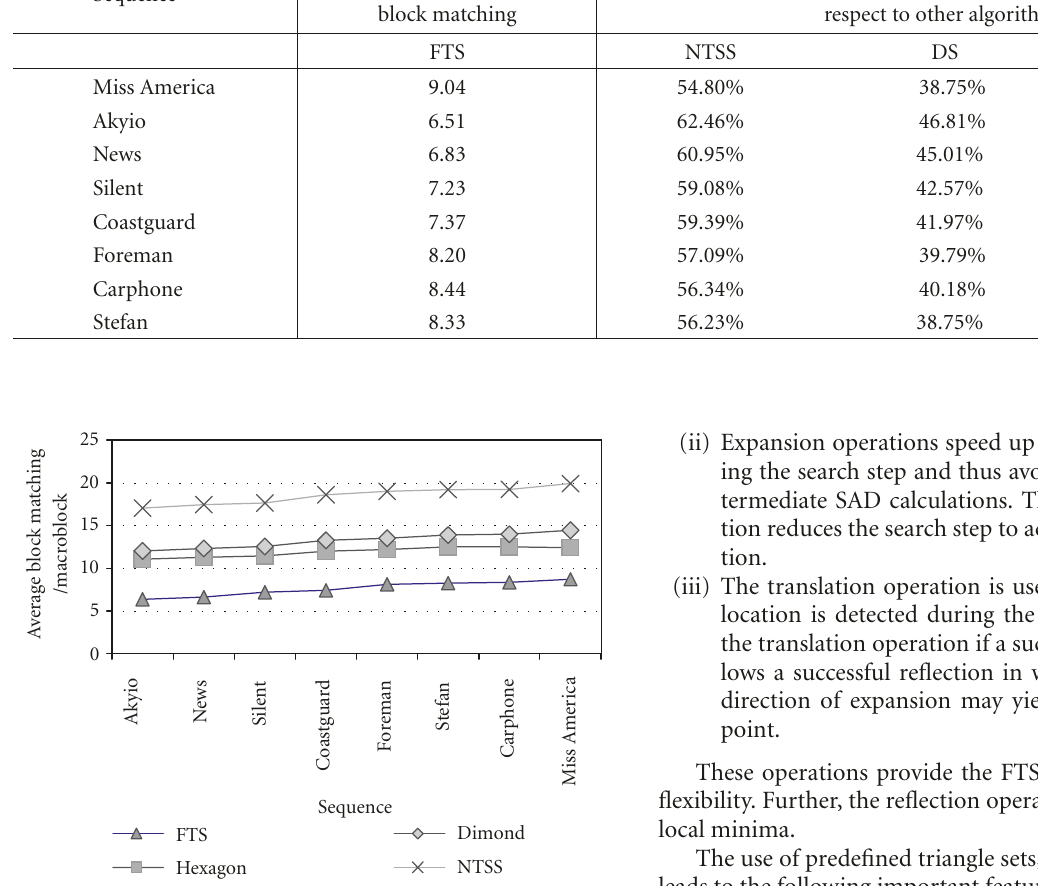
Figure 8: Average number of block matching per macroblock for each